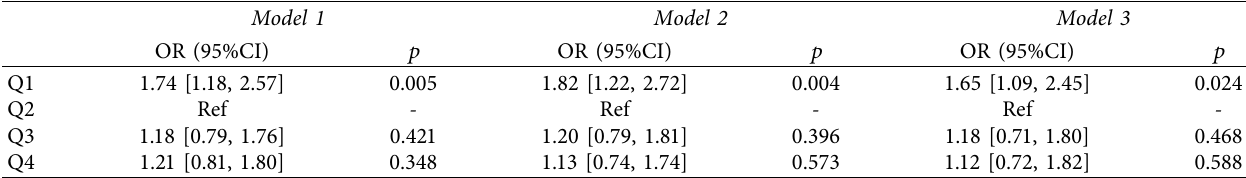
Figure 1: (a) The number of 6-month readmission was calculated according to TyG quartile. (b) The restricted cubic spines showed the odds ratio of readmission based on TyG index. Table 2: The association between TyG quartile and 6-month readmission of HF patients.